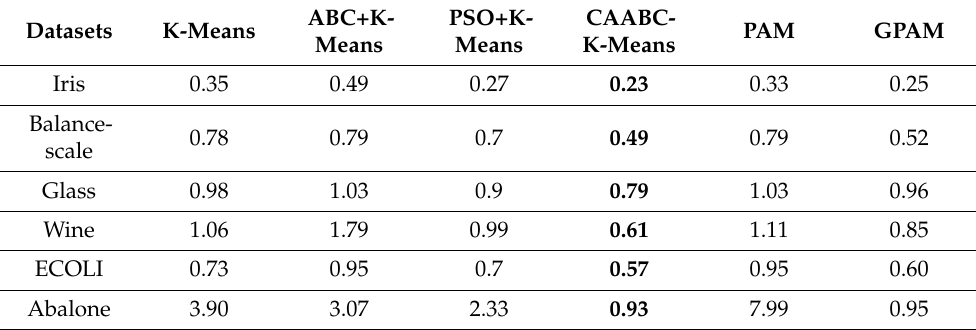
Table 8. The average running time (sec.) for classifying the eleven training